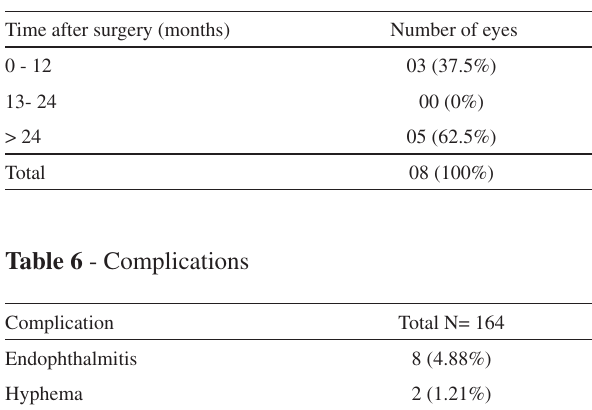
Table 3 - Success and failure correlated with previous sur- gery